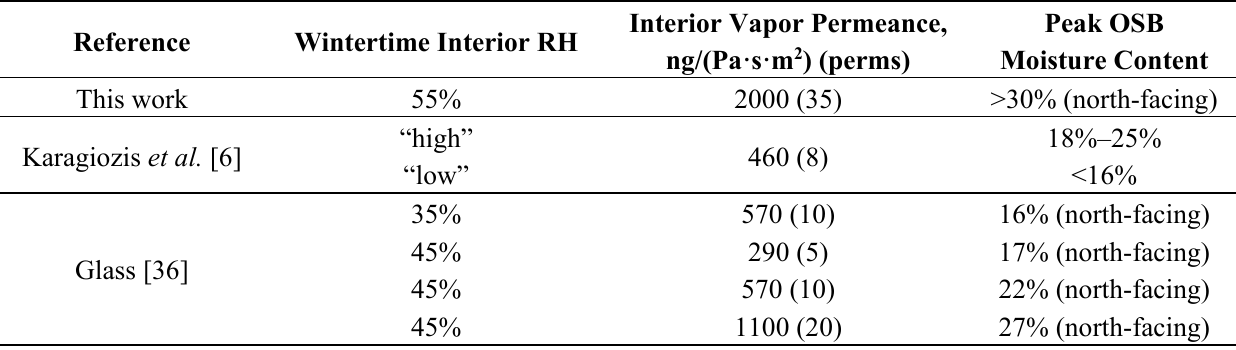
Table 3. Comparison of hygrothermal